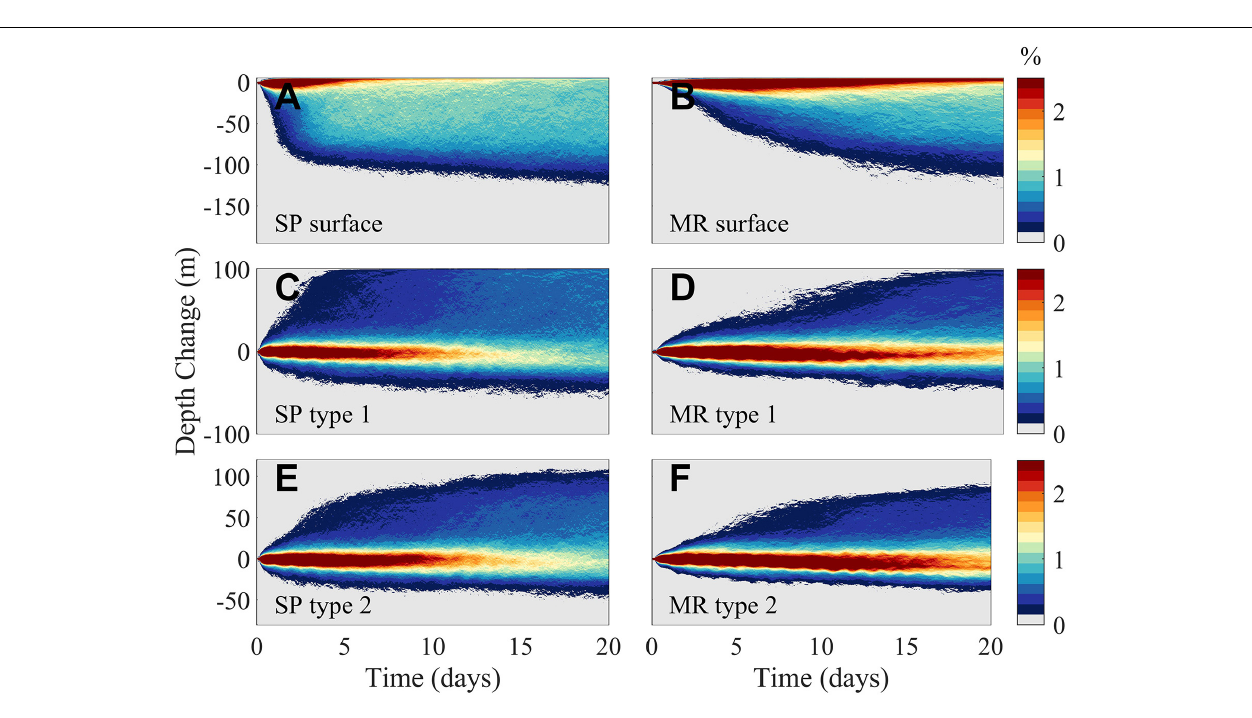
in the areas with the strongest submesoscale vertical velocities accompanied by a deep mixed layer, i.e., in the “submesoscale soup” and at the periphery of the LC eddy and in the region between the Ring and the LC. Upwelling and downwelling patterns are similar among them and across ensemble